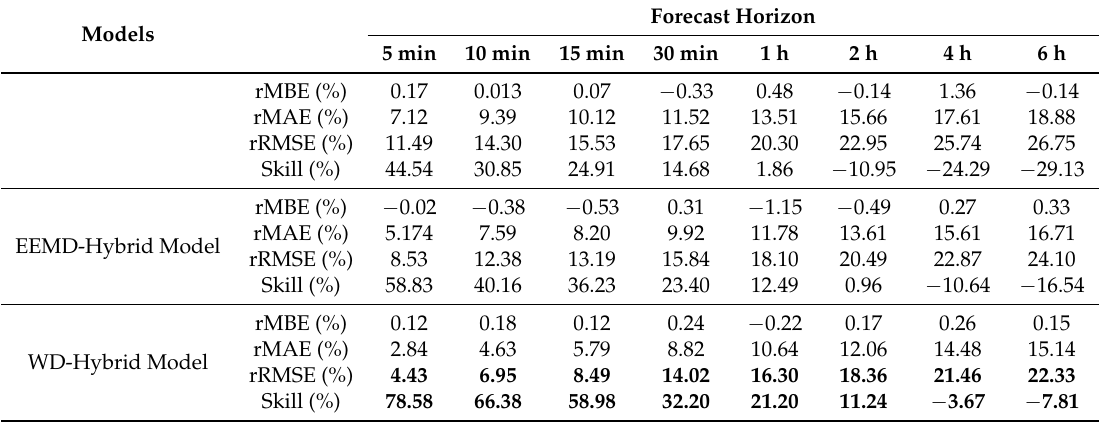
Figure 7. Hybrid model flowchart adapted to Strategy 2; the fuchsia case indicates the modified step. Table 2. Forecasting performance of the Hybrid model according to the forecasting horizon with a data sampling = 5 min (Strategy